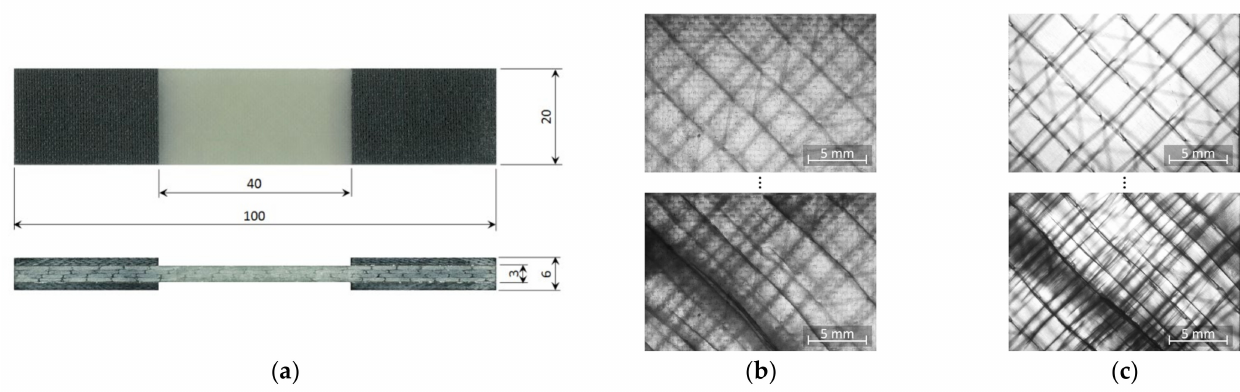
Figure 1. ( a ) Overview of the coupon specimen geometry for quasi-static and fatigue testing (all dimensions in mm); ( b ) transmitted light images of the regular laminate with peel-ply artefacts (undamaged/damaged); ( c ) transmitted light images of the polished laminate